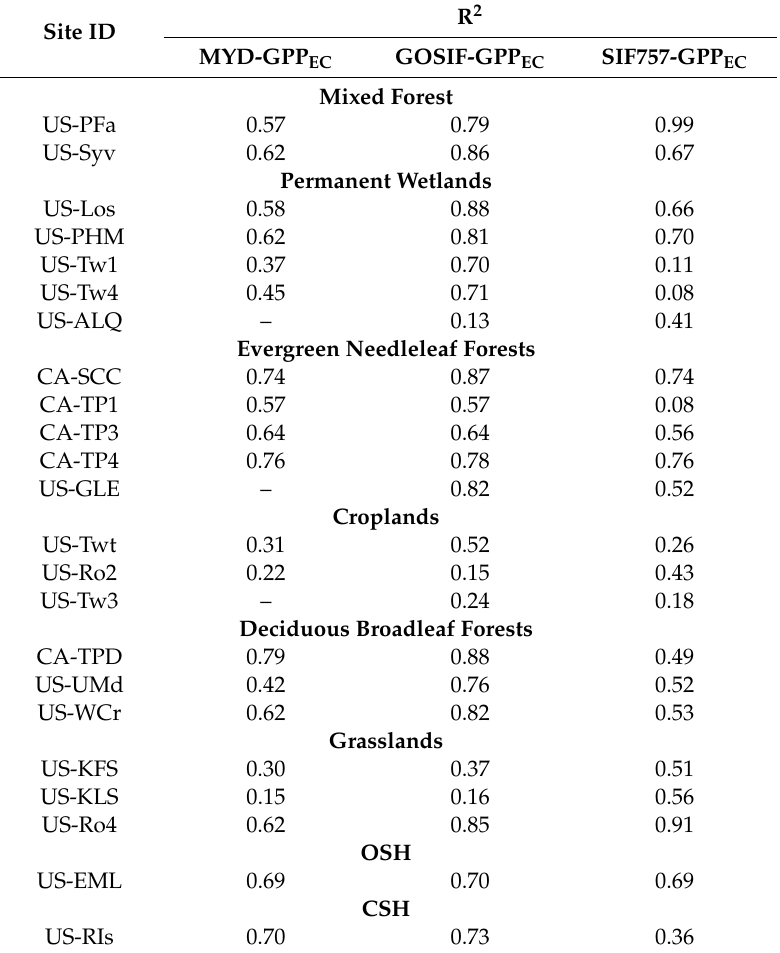
Table 4. Comparisons of correlation coe ffi cients between the MODIS, GOSIF, SIF757, and EC gross primary production (GPP) at a single tower (parameter: R 2